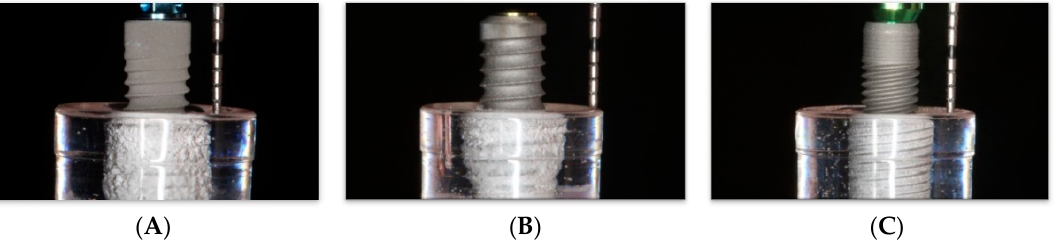
Figure 2. Implants embedded in epoxy resin with 6 mm of surface exposed. ( A ) Straumann; ( B ) BioHorizons; ( C ) Zimmer.